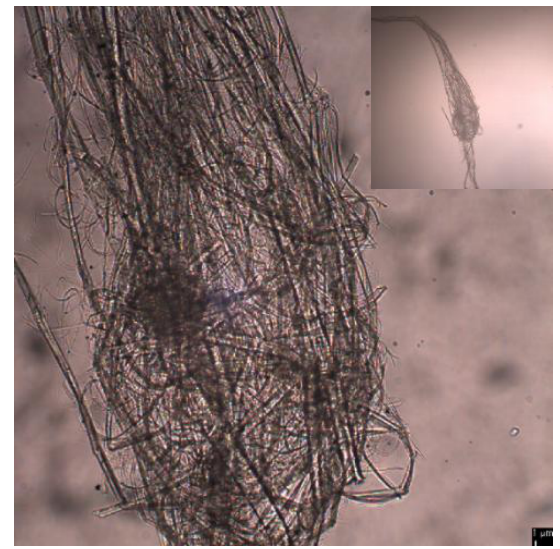
Figure 4. Optical microscopic image of entangled TEMPO-oxidized PMBFs after ultrasonic treatment at pH 3.